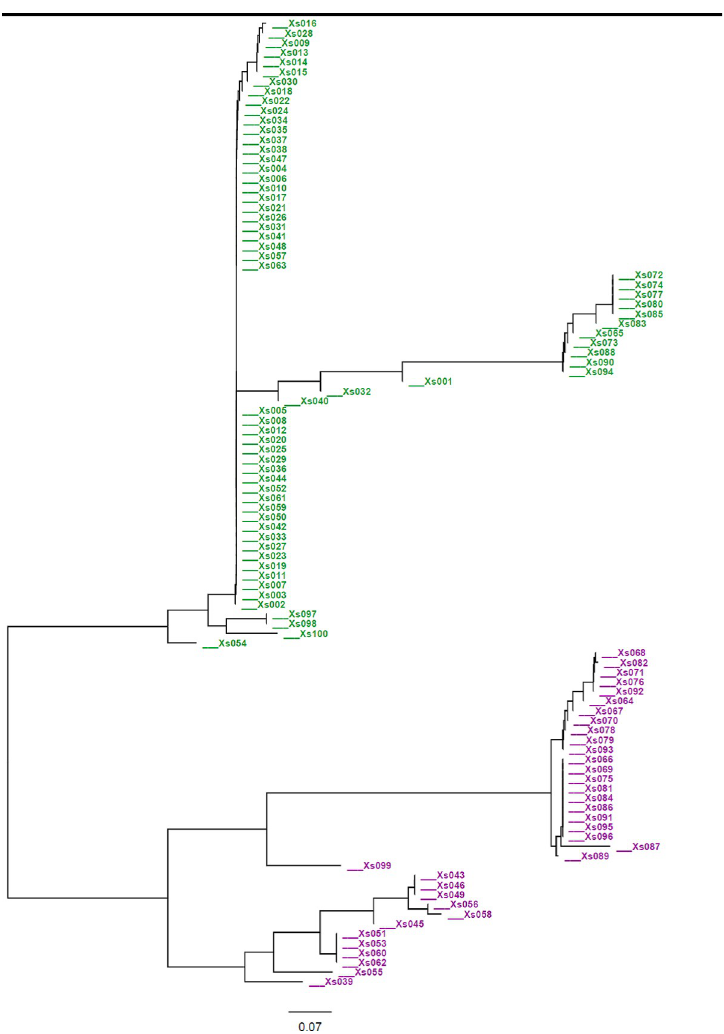
Fig 3. Neighbour joining tree showing the relationships among Ethiopian cocoyam accessions. The tree was generated based on Nei’s genetic distance using 11 microsatellite markers. Green- and purple- represent green- and purple- cocoyam accessions. The accessions Xs001-Xs014, Xs015-Xs026, Xs027-Xs054, Xs055-Xs082 Wolaita and Xs083—Xs100 were from Bench-maji, Kefa, Dawuro, Wolaita and Gamo-Gofa zones, respectively.